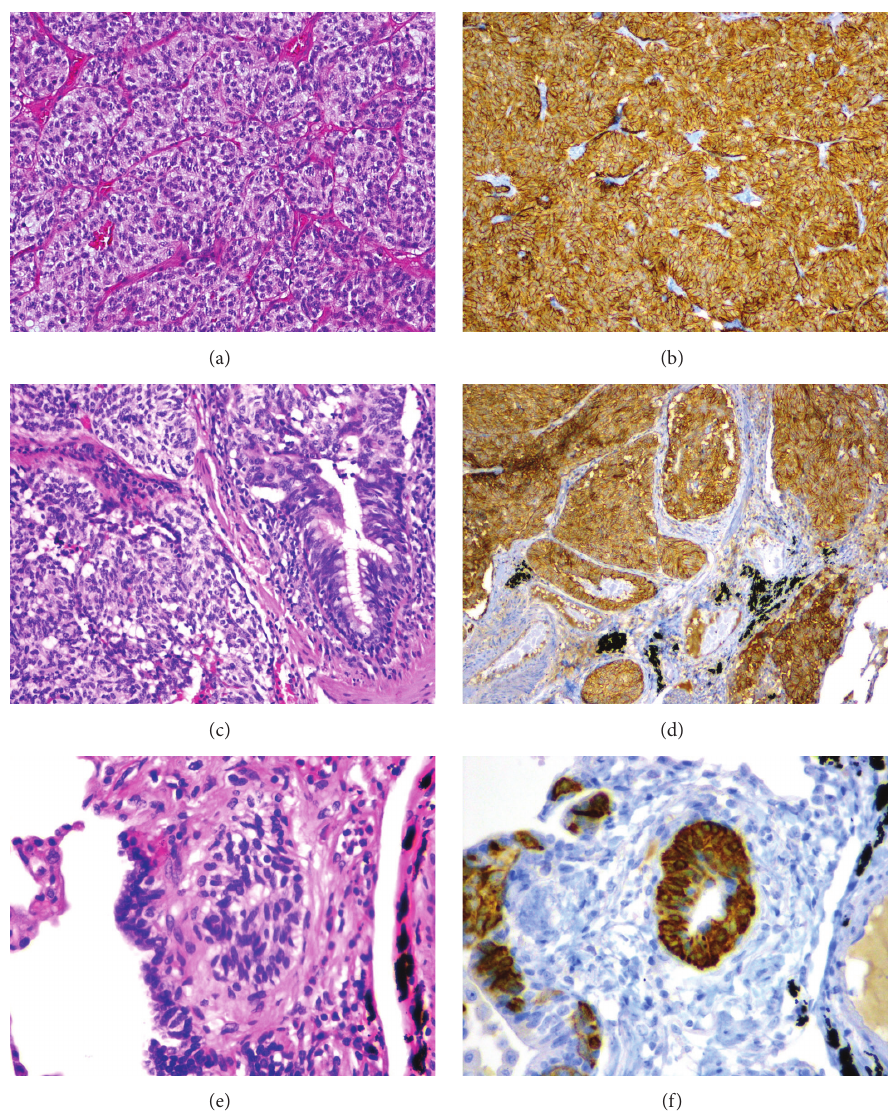
Figure 1: Case 1. (a) Carcinoid tumor. (b) Carcinoid with strong and diffuse expression of CD56. (c) Tumorlet. (d) Tumorlet also showing strong and diffuse expression of CD56. (e) DIPNECH. (f) Strong expression of chromogranin A in